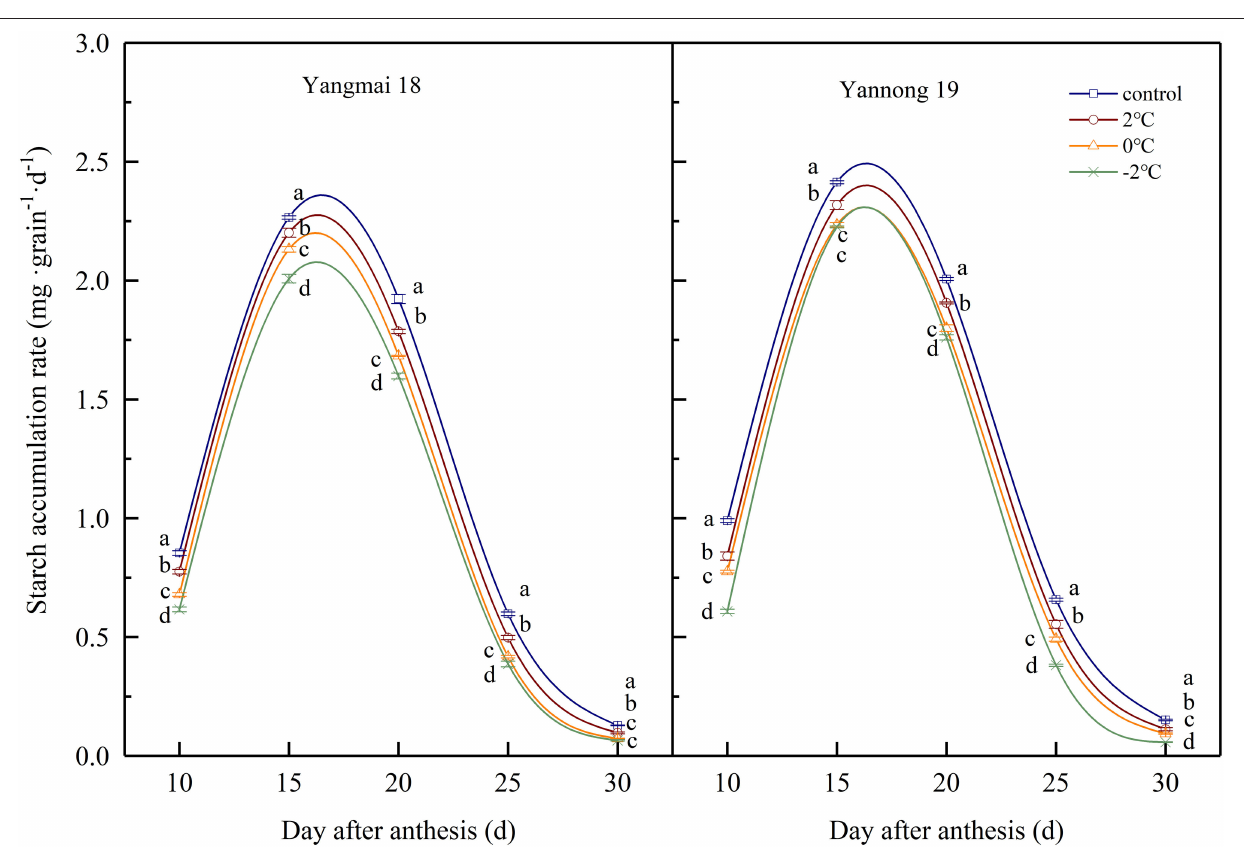
Frontiers in Plant Science |